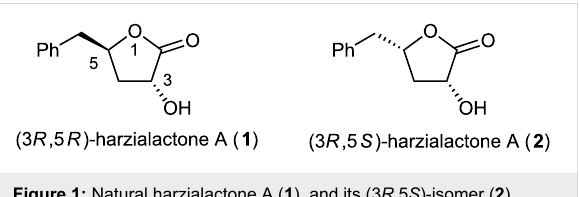
formations. 3 can be made by hydroxyl directed reduction of 4 dithiane 5